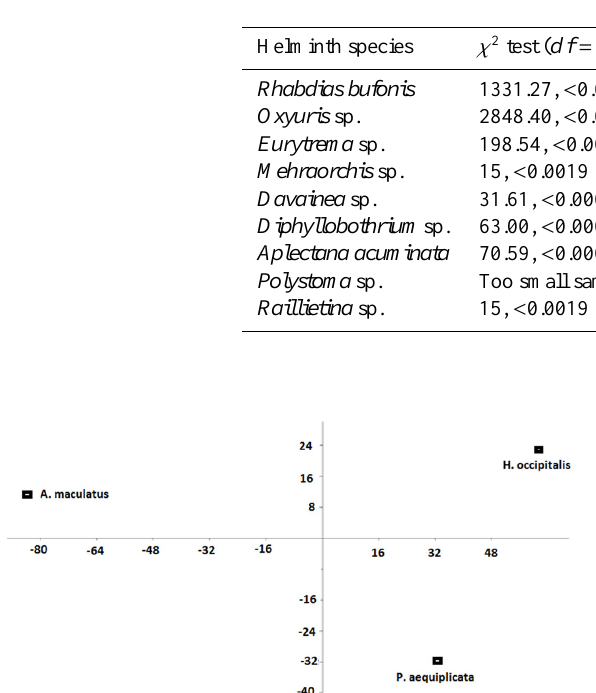
Table 2. Results of statistical analysis showing di ff erent species-specific preferences of helminth species for particular sectors of the gas- trointestinal system of anuran species from Port Harcourt, Nigeria. When a same helminth species occurred in more than one anuran species, statistical analyses were performed on pooled numbers.